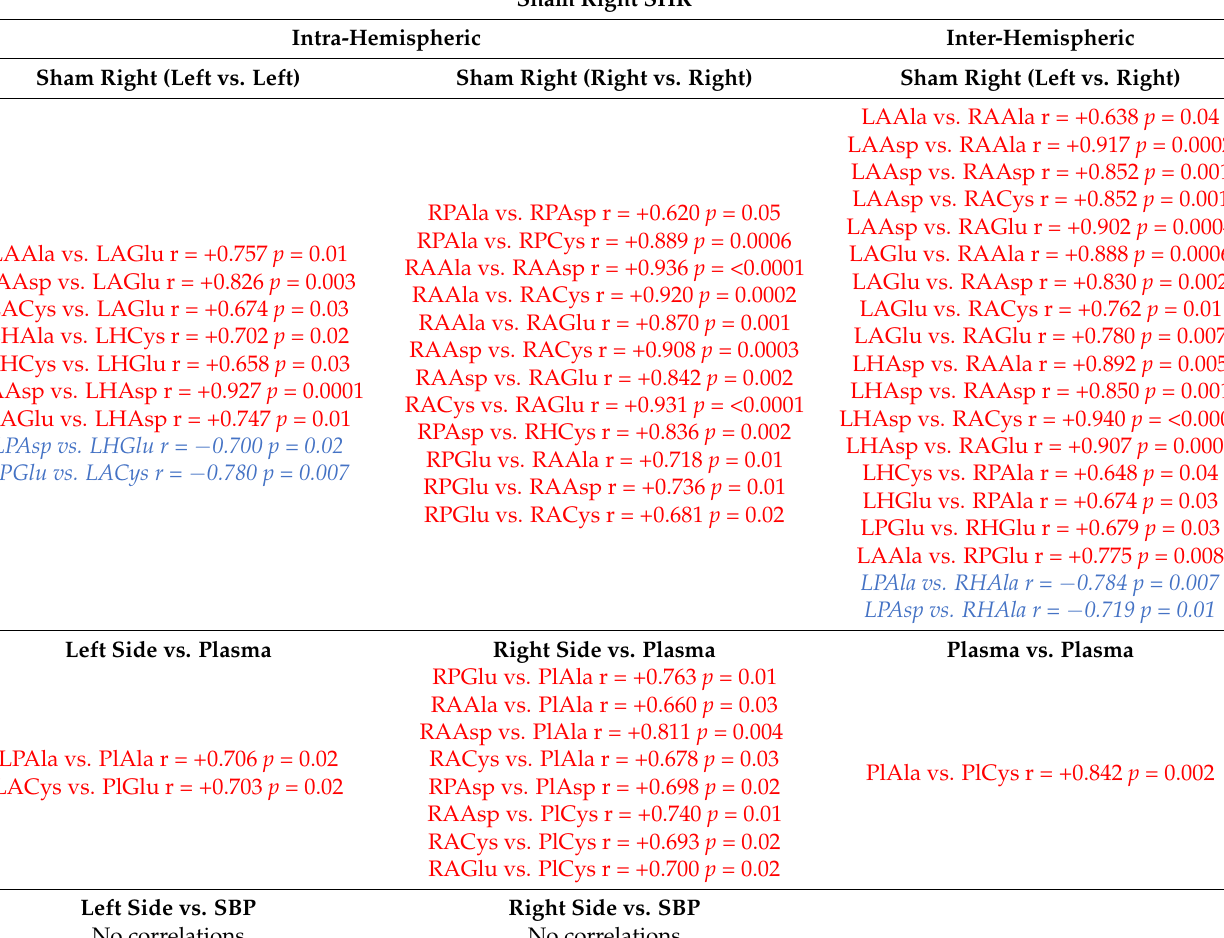
No correlations No